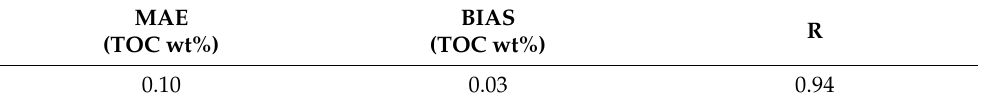
Table 2. Leave one out cross-validation estimates of the median polish kriging